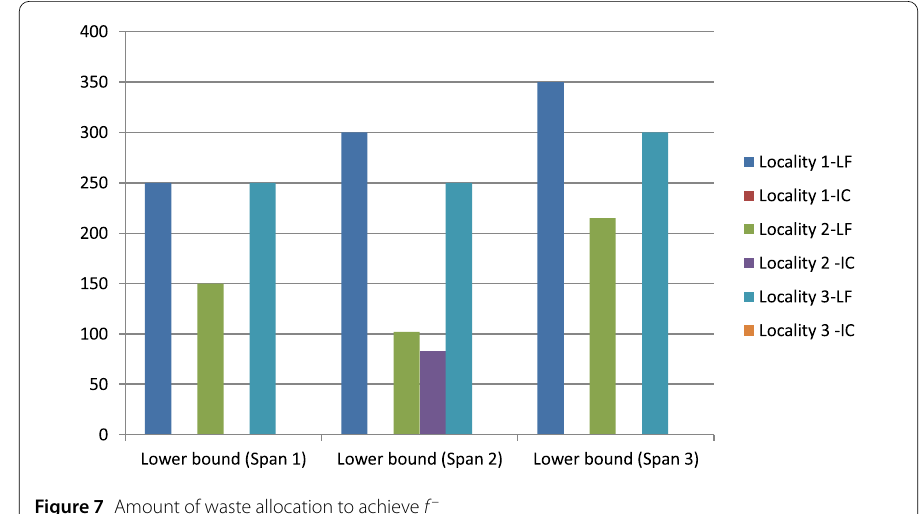
Figure 7 Amount of waste allocation to achieve f –